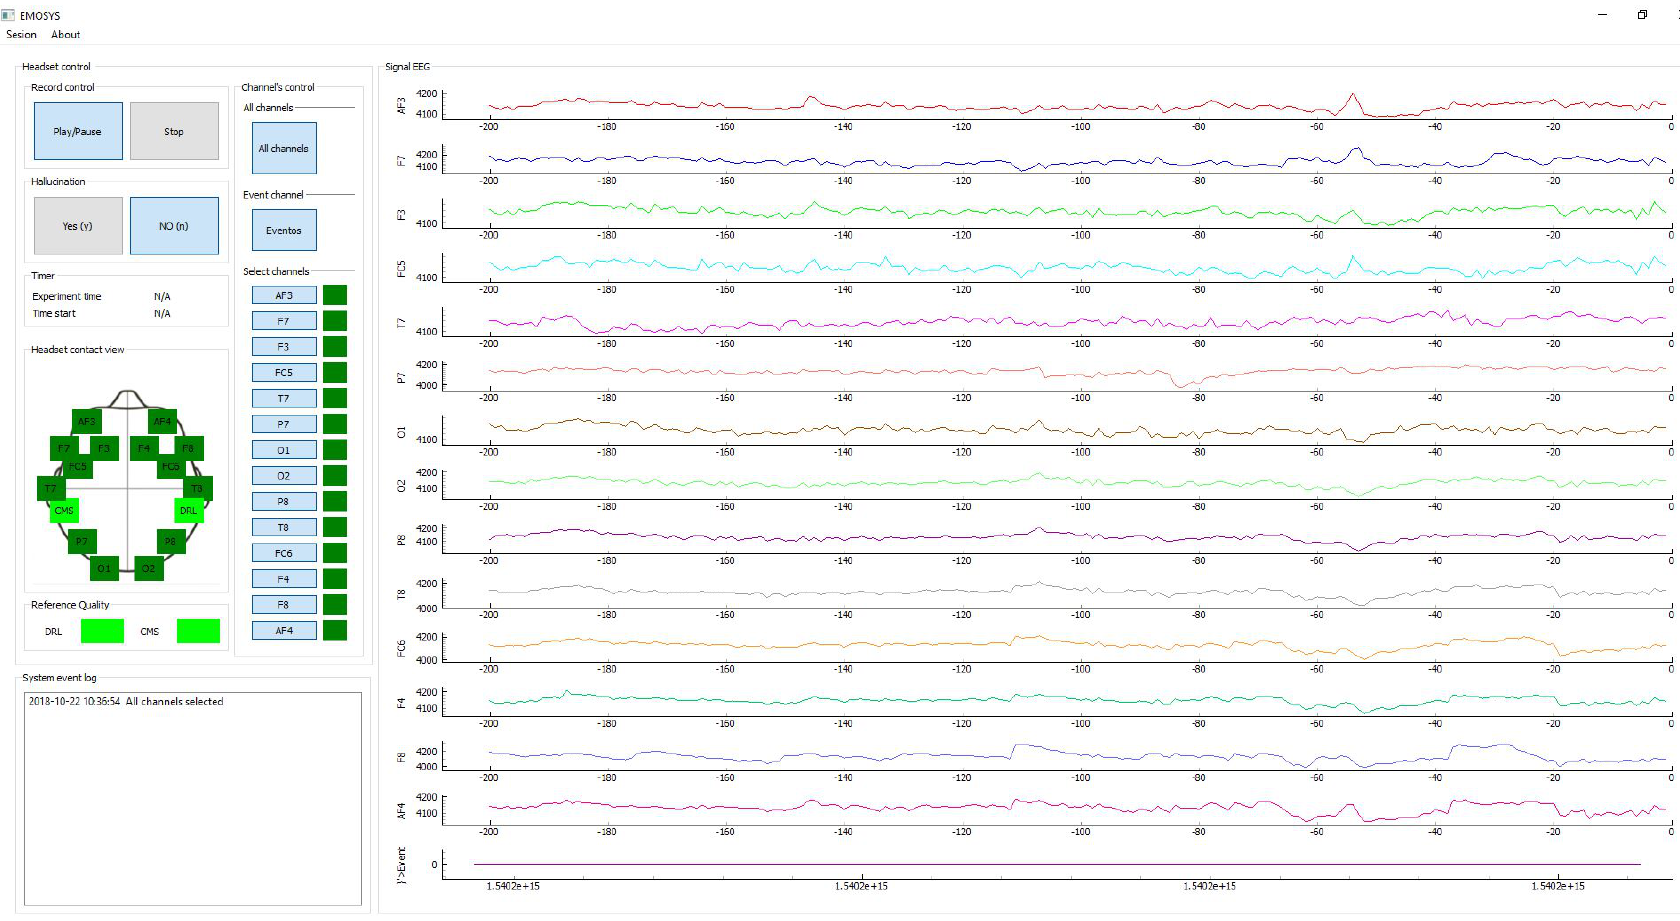
Figure 3. EmoSys user interface showing data received from Emotiv EPOC+